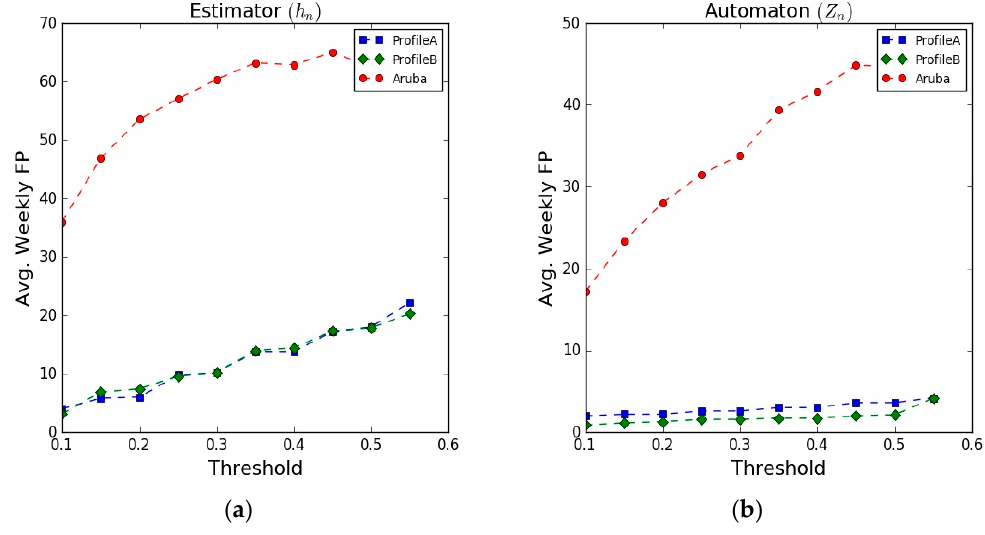
Figure 11. Average of Weekly False Positive alerts. ( a ) Estimator results; ( b ) Automaton results.